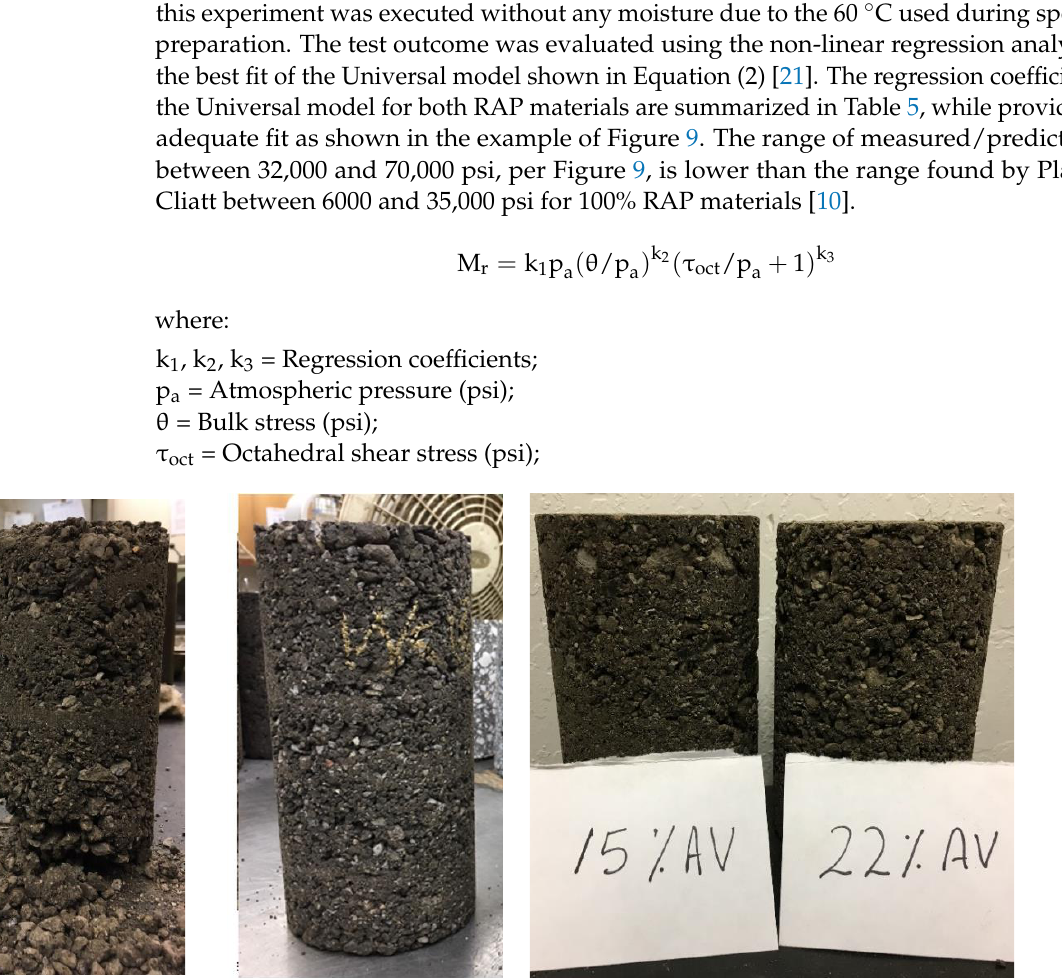
Table 4. RAP millings maximum dry density and optimum moisture contents.